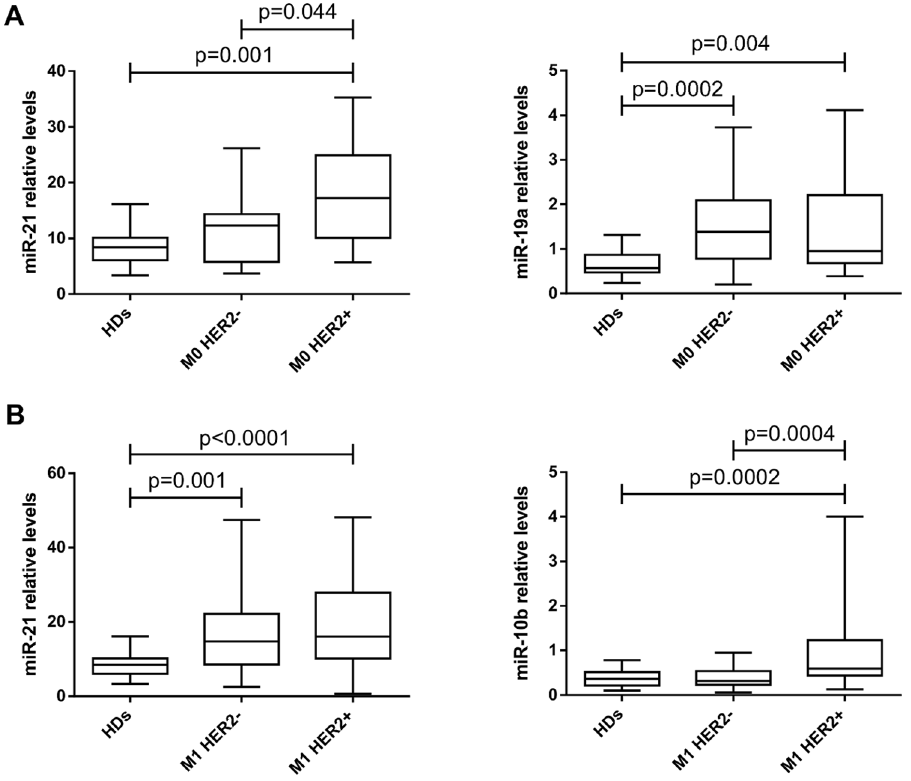
Figure 2. Serum miRNA levels in patients with M0 HER2 + , M0 HER2 2 , M1 HER2 + , M1 HER2 2 breast cancer and HDs. The box plots show: a) relative serum miR-21 and miR-19a levels in patients with M0 HER2 + and M0 HER2 2 breast cancer; and b) relative serum miR-21 and miR-10b levels in patients with M1 HER2 + and M1 HER2 2 breast cancer. Thirty HDs were included as a control group. The differences in serum levels were evaluated using the Mann-Whitney U test, and the p values are indicated above the plots.